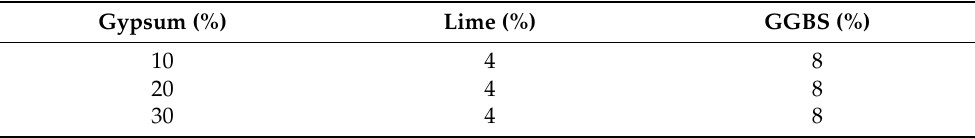
Table 3. Proportions of the materials (by dry weight of